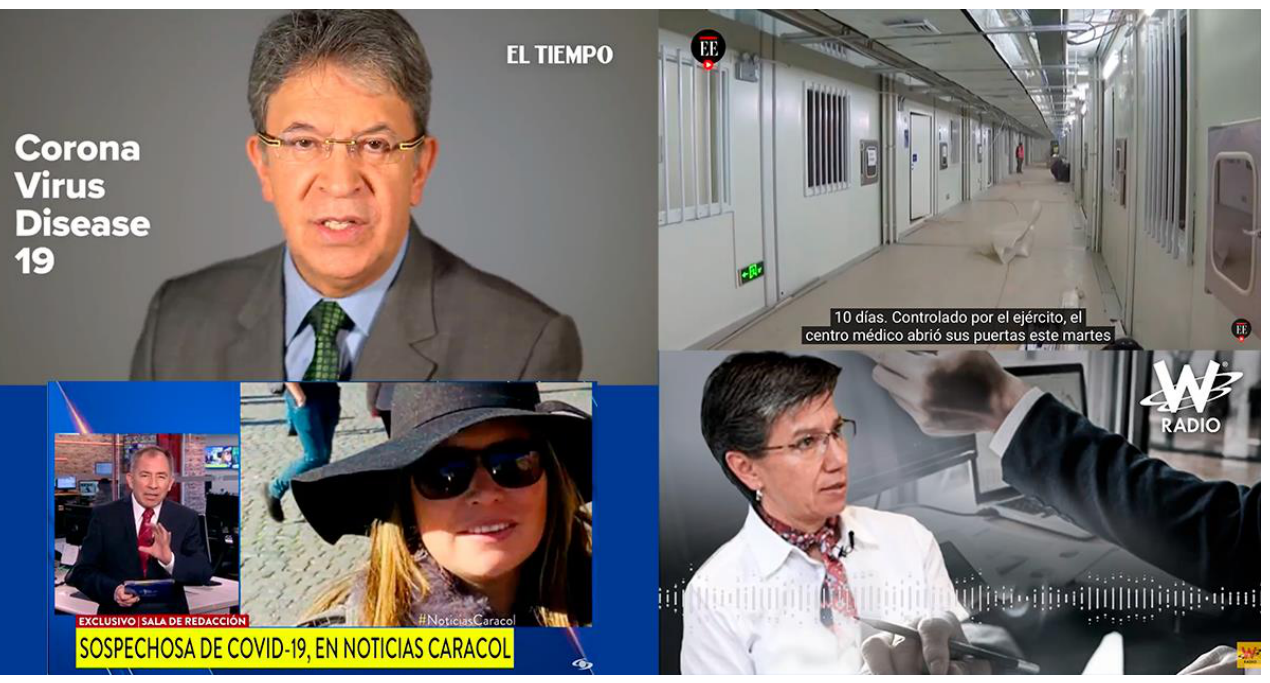
Figure 6. Composition of the audiovisual message on networks. Prepared by the author with images taken from social networks.